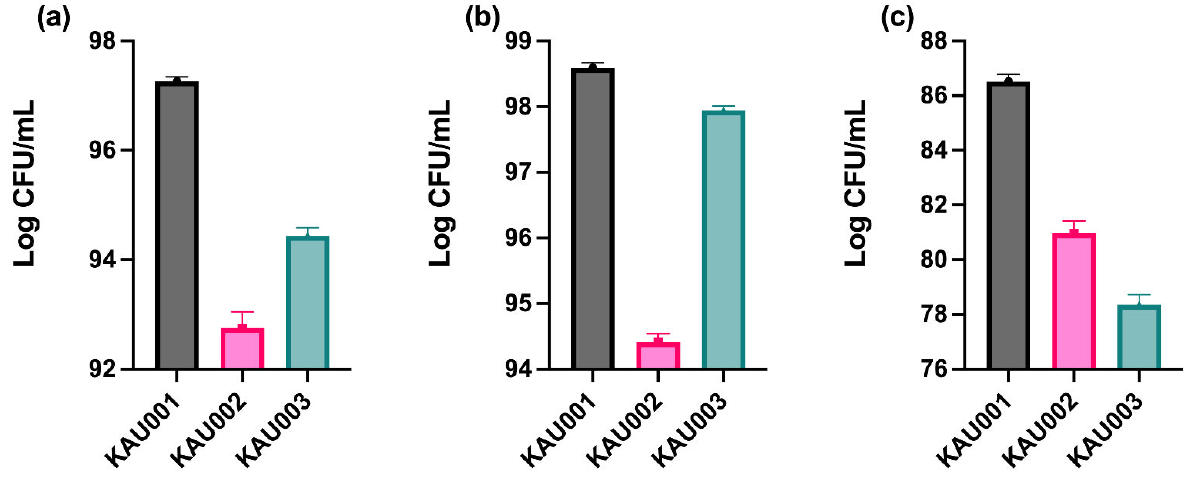
Figure 1. Characterization of three selected LAB isolates from fermented Ajwa dates. ( a ) Acid toler ‐ ance. ( b ) Bile tolerance. ( c ) Intestinal adhesion activity. Data are expressed as mean ± S.D. from three independent experiments.